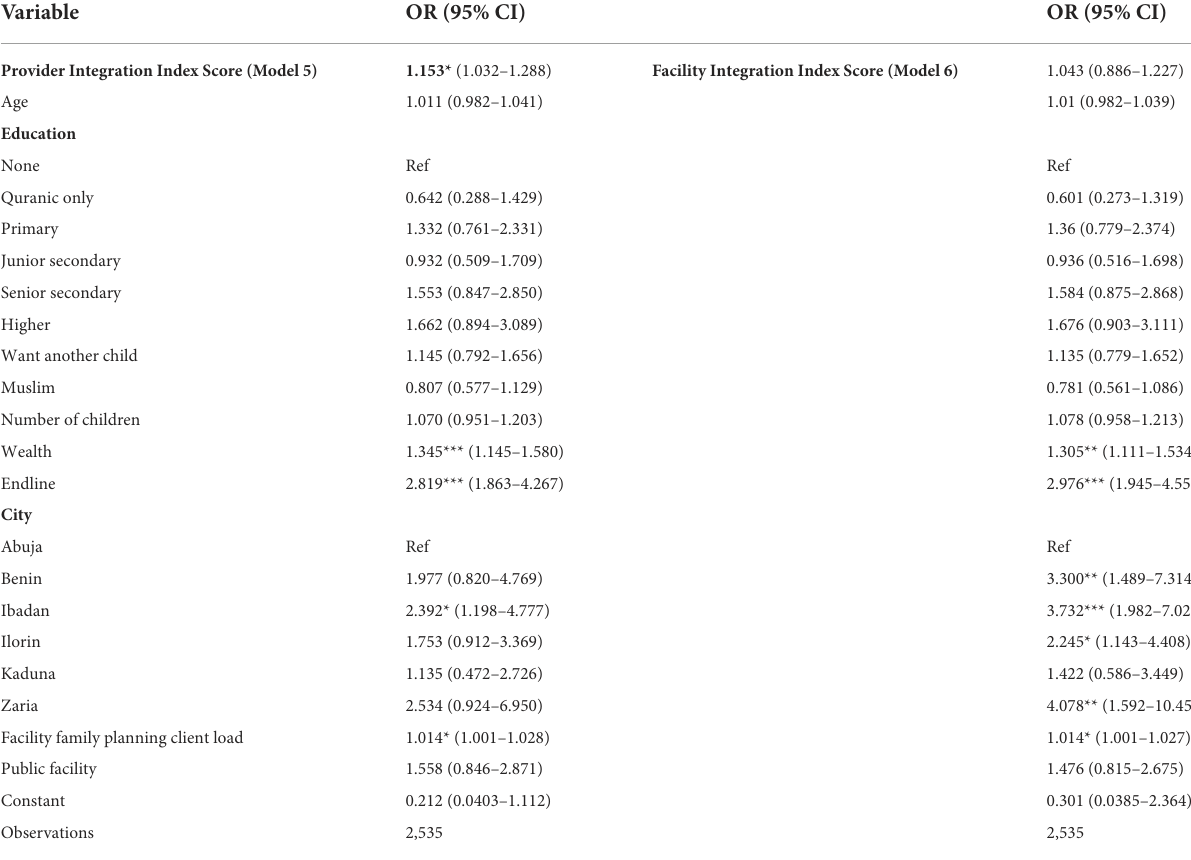
TABLE 4 Association between provider and facility integration index scores and correct identification of family planning service availability at